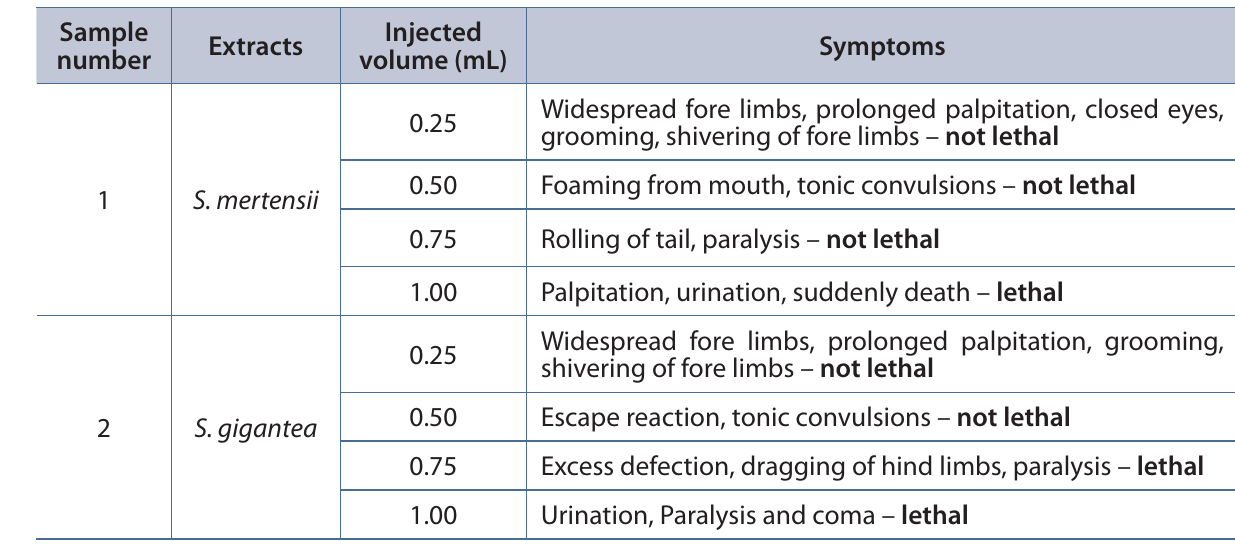
Table 1. Mouse toxicity of sea anemones S. mertensii and S. gigantea samples at 5.0 mg/mL intraperitoneally injected into male albino mice (20 ± 2